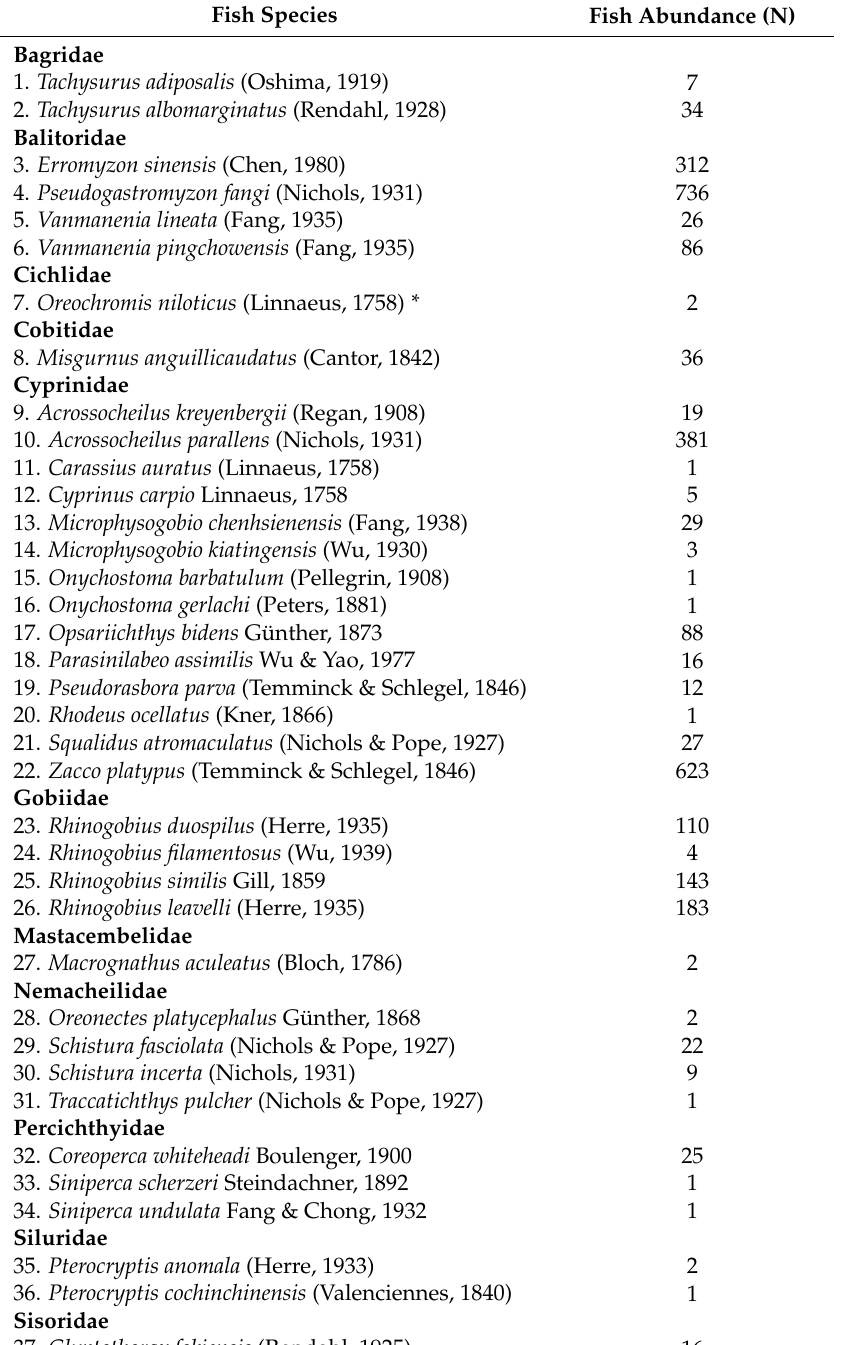
Table 3. Fish species and abundance collected in upstream Lijiang